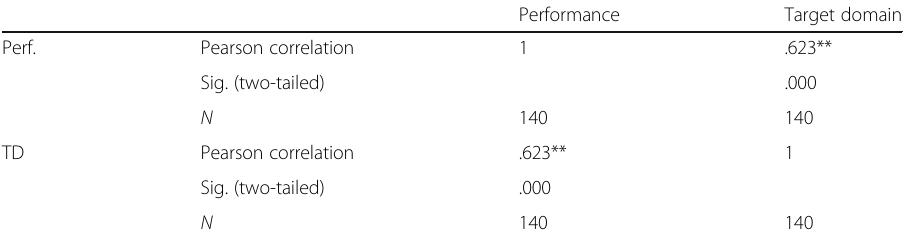
Performance Target domain